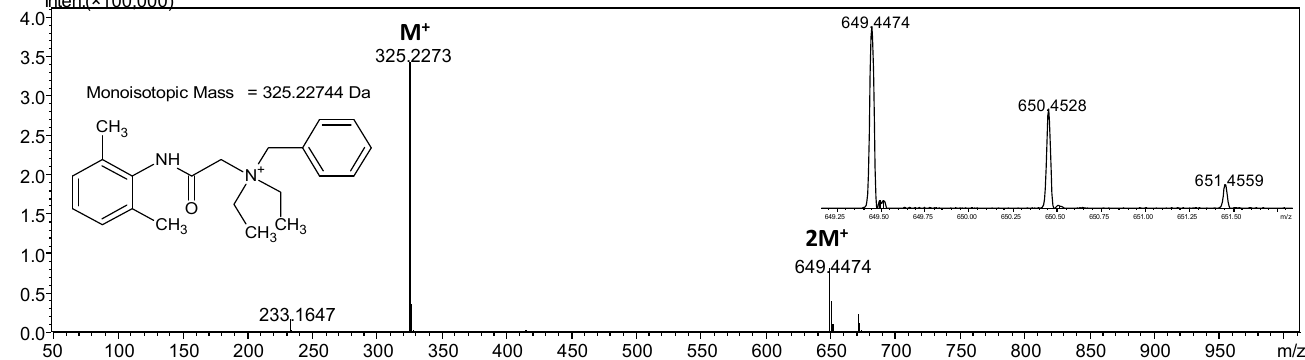
Figure 1. ESI-MS spectrum of denatonium cation in the positive ion mode. m / z range from 50 to 1000.